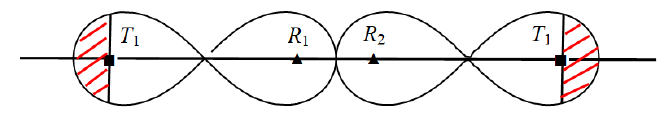
Figure A6. External coverage area of homogeneous BR sequence T 1 − R n − T 1